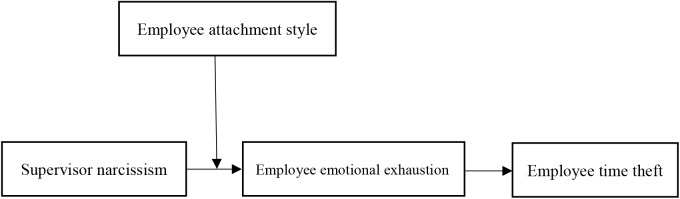
Theoretical model.